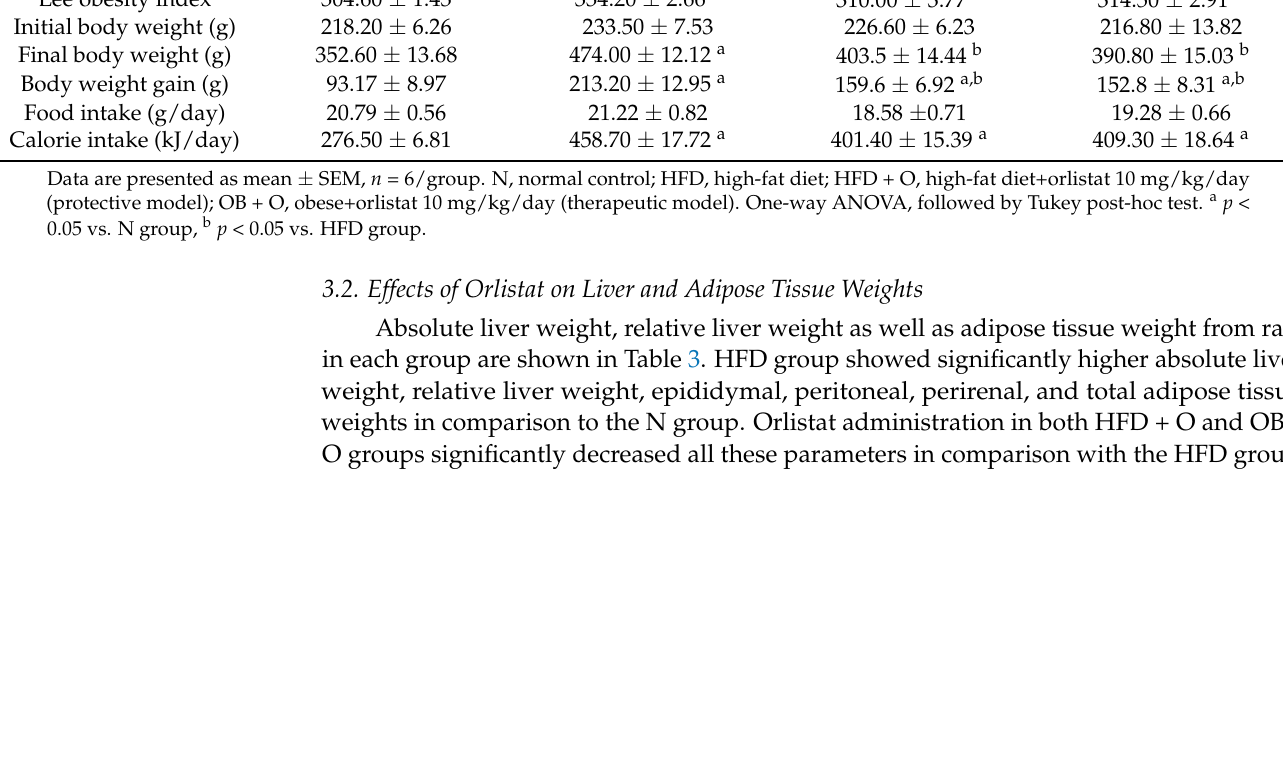
Table 2. Lee obesity index, body weight gain, food intake and calorie intake of rats in the experimental groups.